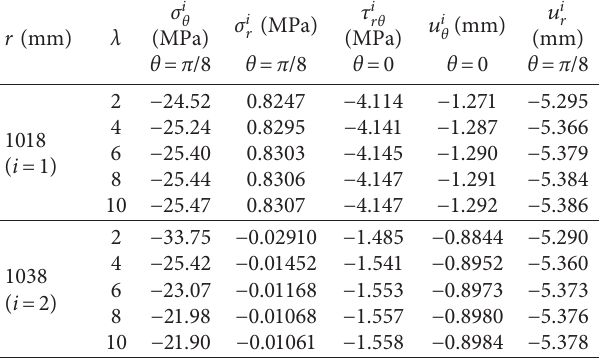
Table 2: The present solution of stresses and deformations in the face layer ( i � 1) and permeation layer ( i � 2) with different sublayer divided number λ ,